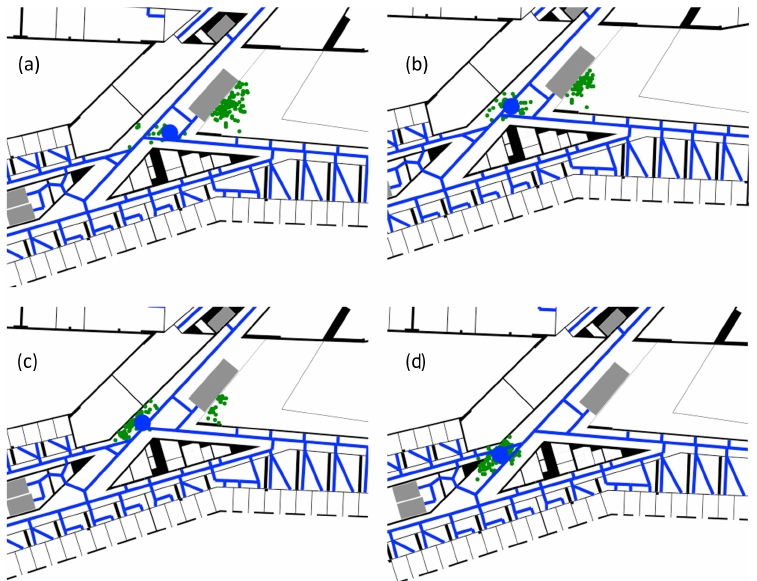
Figure 11. Example of the trajectory correction (from ( a – d )) through the backtracking functionality, where the green dots represent the valid, propagated particles, and the blue dot is the resulting position estimate. First, most particles took a “wrong” path ( a ), continuously getting deleted when trying to pass the wall ( a – c ). While more particles are getting deleted, more particles with plausible trajectories are getting created through the backtracking process, until all particles are recovered and now only represent positions with reasonable trajectories again ( d ).